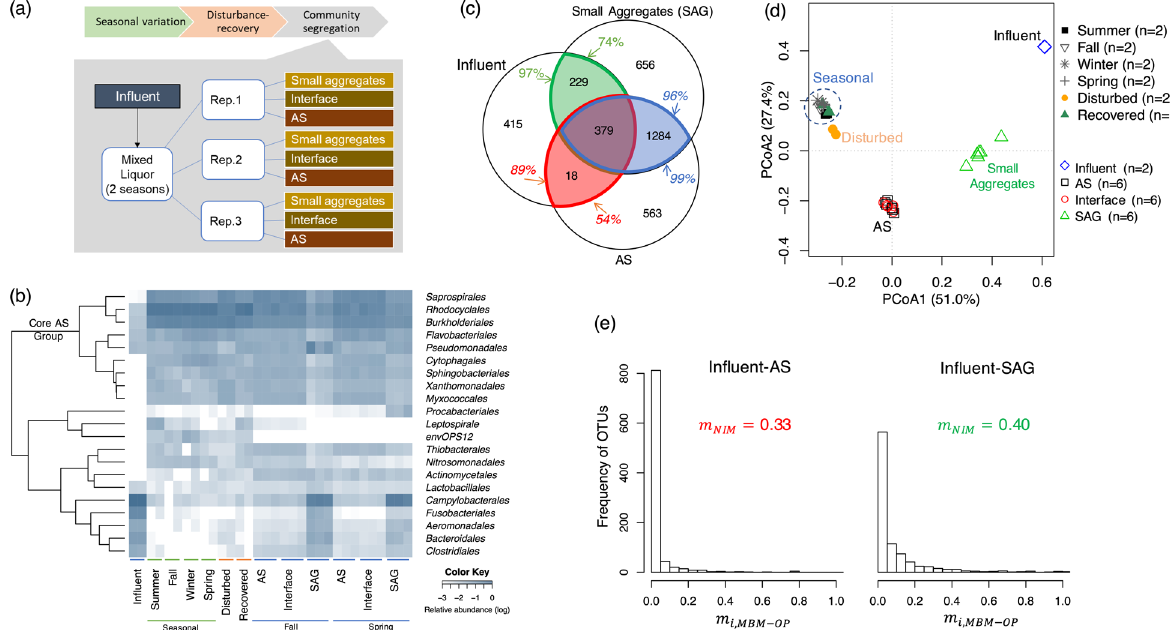
Fig. 1 Sampling strategy, microbial community composition and diversity, and modeled in fl uent immigration. a Schematic chart of sample collection. b Assembly of the top 10 abundant bacterial orders from in fl uent and AS. c Venn diagram of shared OTUs among in fl uent, activated sludge (AS) and small aggregates (SAG), and the relative abundances of shared OTUs. d PCoA of Bray-Curtis distances among the set of seasonal AS communities and high- fl ow disturbed and recovered communities (pyrosequencing), and the size-separated bioreactor samples (Illumina Miseq sequencing); variation between the long-term data and current data is likely due to different sequencing technologies. e Quanti fi ed in fl uent immigration to AS and SAG using neutral immigration model ( m NIM ) and mass-balance model with operational parameters ( m i, MBM-OP